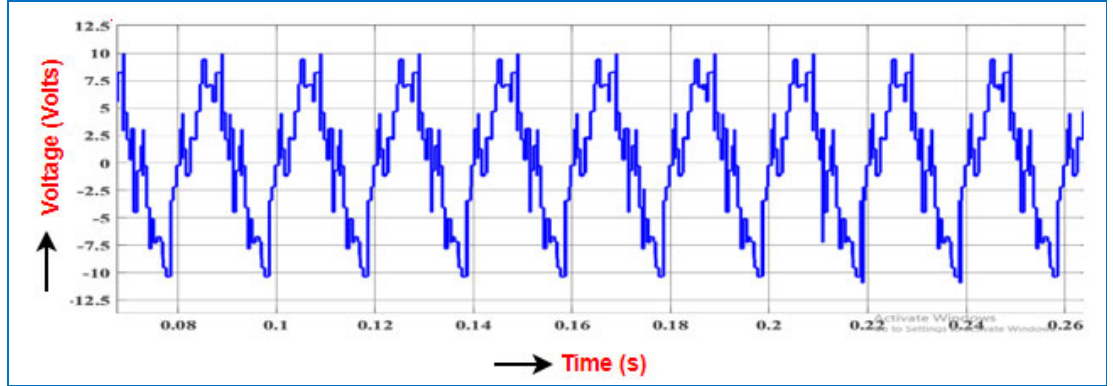
Figure 19. Reduced common mode voltage of H ‐ bridge MLI using MCSPWM.